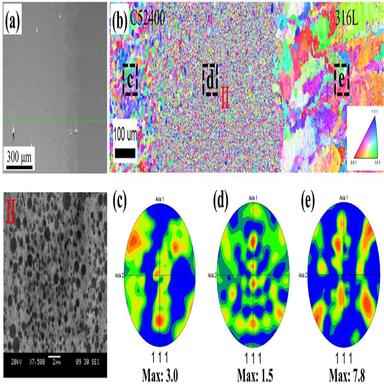
SEM and EBSD images at the SLMed L/C interface: (a) Testing region; (b) EBSD; (c) (d) (e) Pole figures and (II) Microstructure after polishing corresponding to (b).